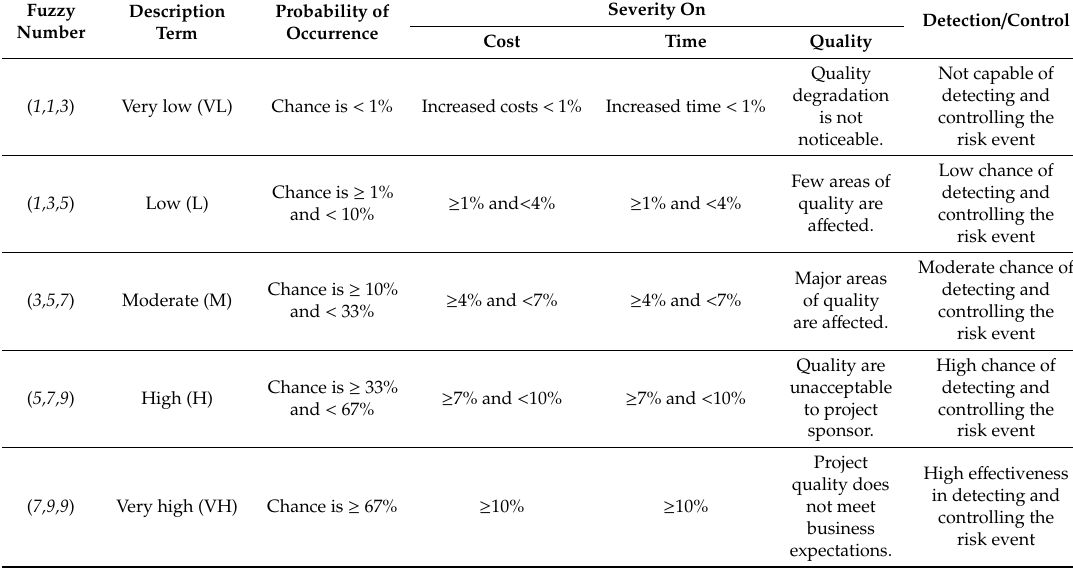
Table 2. Linguistic definition of probability of occurrence, severity, and